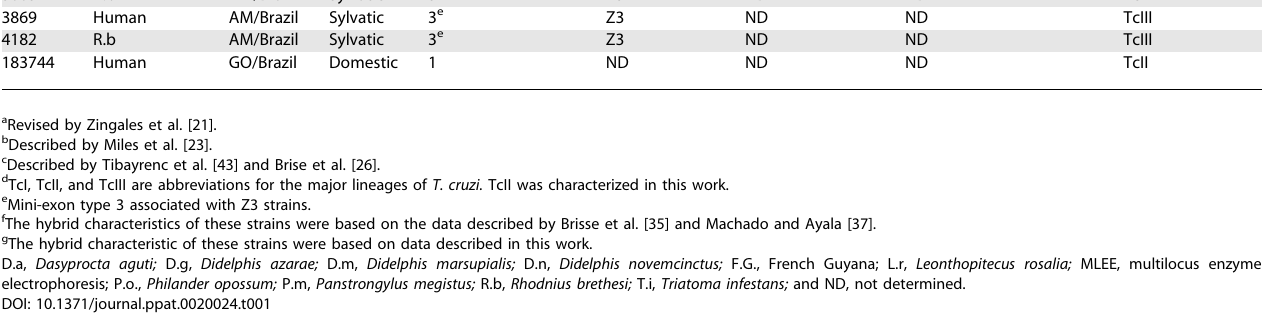
(stress ¼ 0.08), a visual representation of the distance matrix. Four clusters are clearly visible and identified by ellipsoids in the MDS plot. The identity of the clusters is revealed by the presence of the prototypical strains of Brisse et al. [26]: MDS- cluster A corresponds to T. cruzi I, MDS-cluster C to T. cruzi IIb, MDS-cluster B to T. cruzi IIc, and MDS-cluster BH to the clusters: CanIII (sub-lineage IIa), Dog Theis, and 402.